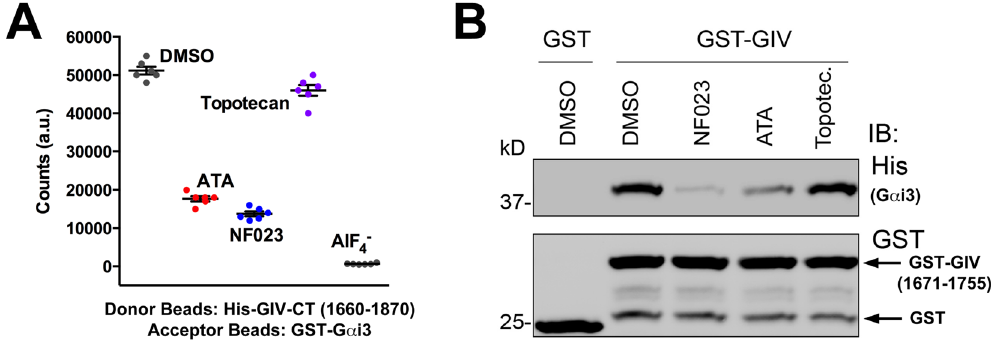
Figure 6. Validation of G α i3-GIV inhibitor hits by independent assays. ( A ) ATA and NF023, but not topotecan inhibit G α i3-GIV binding as determined by the AlphaScreen assay described in Fig. 5. 75 nM proteins (His- GIV-CT and GST-G α i3 protein), 10 μ g/mL of donor beads and 5 μ g/mL of acceptor beads were incubated